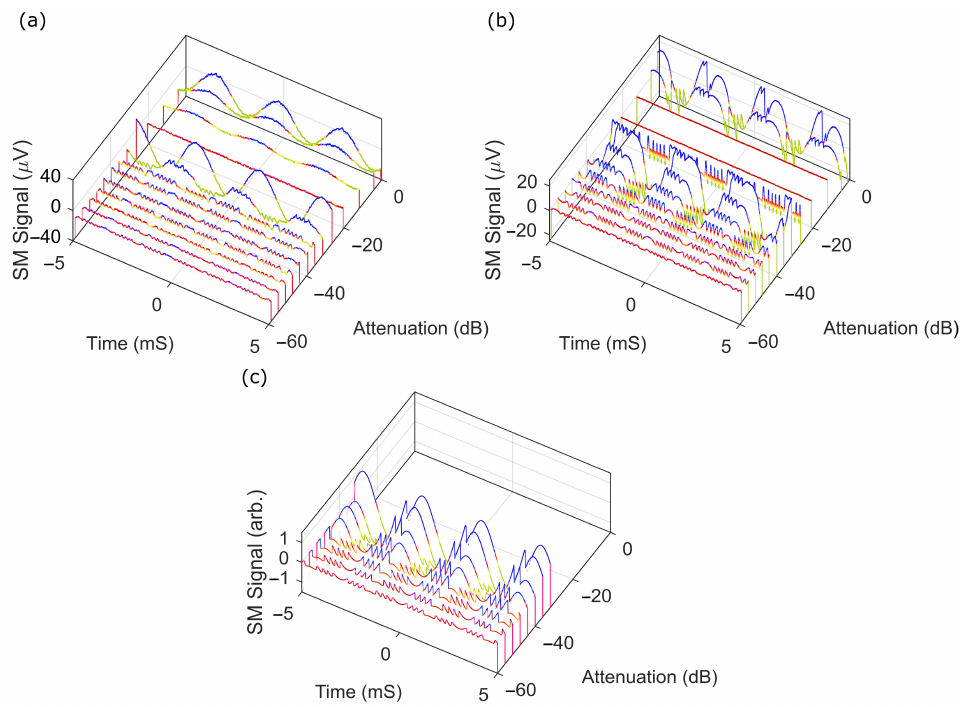
Figure 4. Self-mixing signal for different feedback levels (attenuation in dB) for harmonic displace- ment target. ( a ) VCSEL at a bias current of 7 mA and laser temperature of 35 ◦ C; ( b ) DFB at a bias current of 60 mA and laser temperature of 25 ◦ C; ( c ) simulated